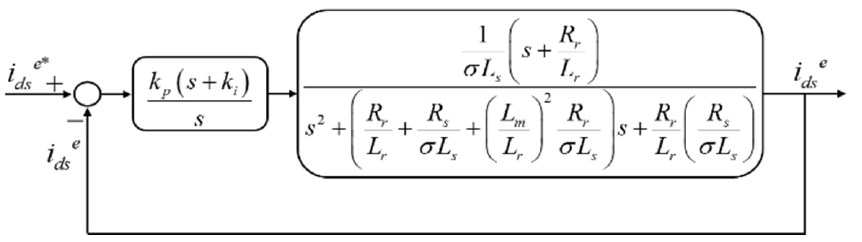
Figure 5. Simplified block diagram of d − axis current controller. A better understanding can be obtained based on Figure 6, where the closed-loop transfer function was interpreted into the pole-zero map plot. The closed-loop transfer function consisted of two poles, labeled as “X”, and one zero, labeled as “O”, that were plotted on the left-hand side of the pole-zero map. This validated that the closed-loop transfer function of the d –axis current controller was in a stable system.